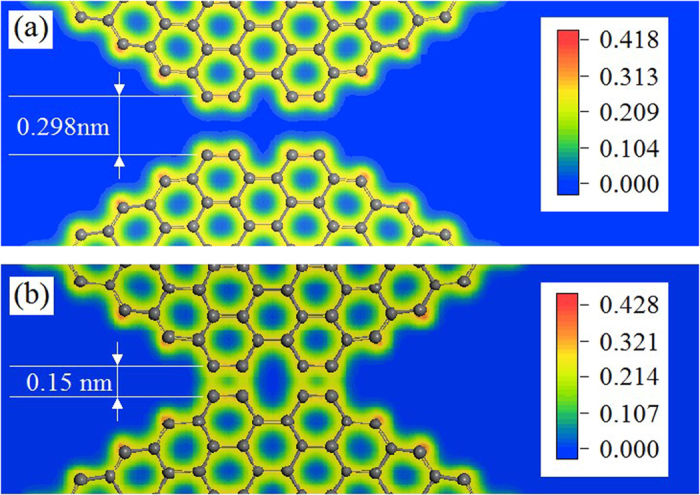
Different contour plot of electron density nearby the neighbour ends of vertical bars in the initial configuration of the pure carbon GK with (a) N(lθ) = 24 (see the upper layer of Fig. 4b) and (b) N(lθ) > 36 obtained by the first principles calculation39.